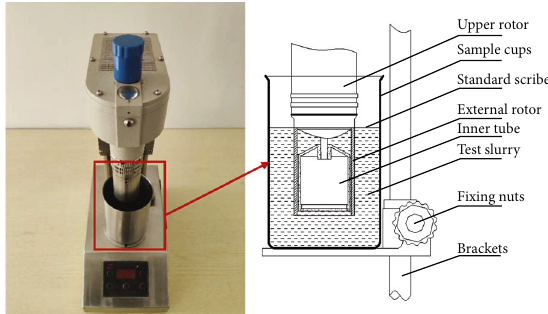
Figure 1: Slurry plastic viscosity test with ZNN-D6X type six-speed rotational viscometer (part of the experimental